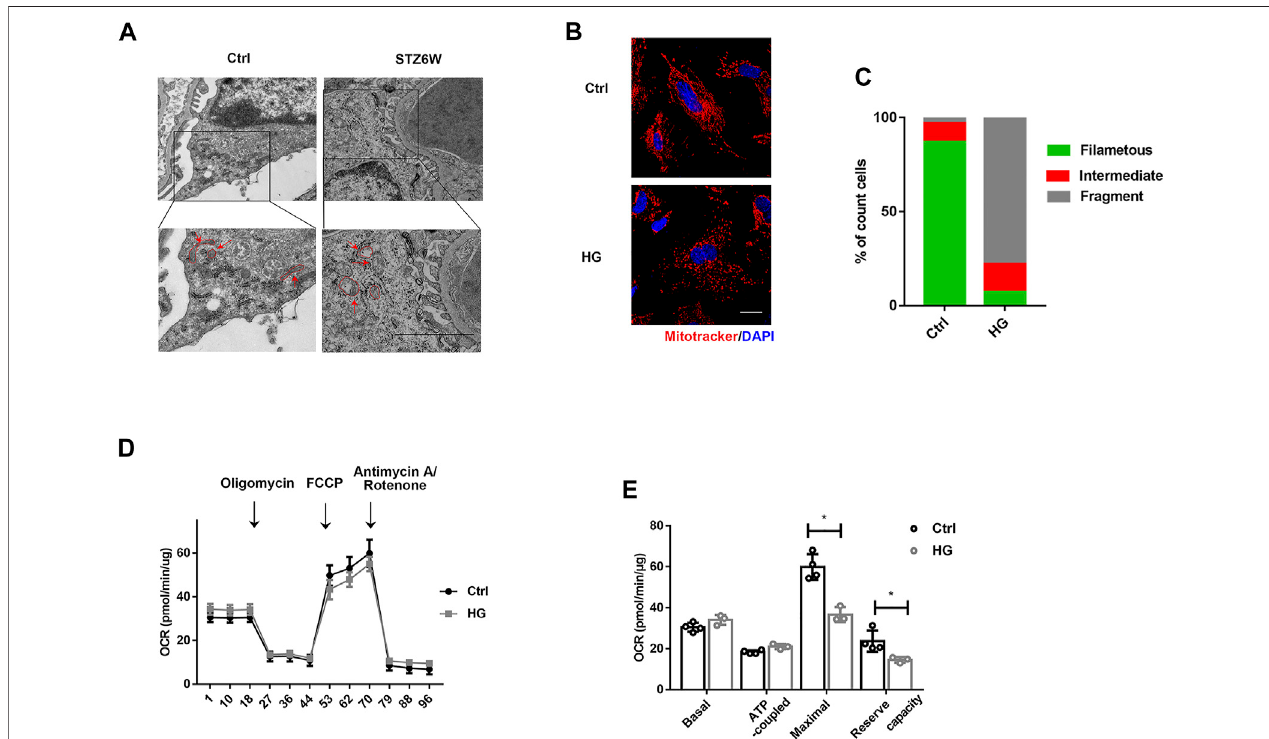
FIGURE 1| HG induces mitochondrial injury in podocytes in vivo and in vitro . (A) Mitochondrial morphology ofpodocytes in control and STZ treated mice. The red arrowsindicaterepresentativemitochondrialmorphologyinthegroups.Electronmicroscopicphotographsshowedthatmitochondriaofnormalpodocyteswerefulland long, and the structure of mitochondrial cristae wasclear, while mitochondrial cristae were decreased and vacuolated in podocyte from diabeticmiceat weeks 6. (Bar (cid:1) 2.5 μ m). (B) Confocal images showing mitochondria. Cells in 6-well plates were challenged with HG (30 mM) for 24H and labeled with MitoTracker Red (red) and DAPI (blue). Mitochondria images were captured using a confocal microscope. As shown in the images, HG treatment shifted the mitochondria from threadiness into fragmentation. (Bar (cid:1) 2.5 μ m). (C) The histogram showing the percentage of different mitochondrial morphologies in mice with indicated genotypes. (50 fi elds were randomly selected for statistics). (D) Representative traces showing OCR in control and HG-treated podocytes. Cells in a XF24-well microplate were treated with or without HG (30 mM) for 24 h. (E) Statistical analyses of baseline respiratory capacity, ATP-coupled respiratory capacity, maximum respiratory capacity, and